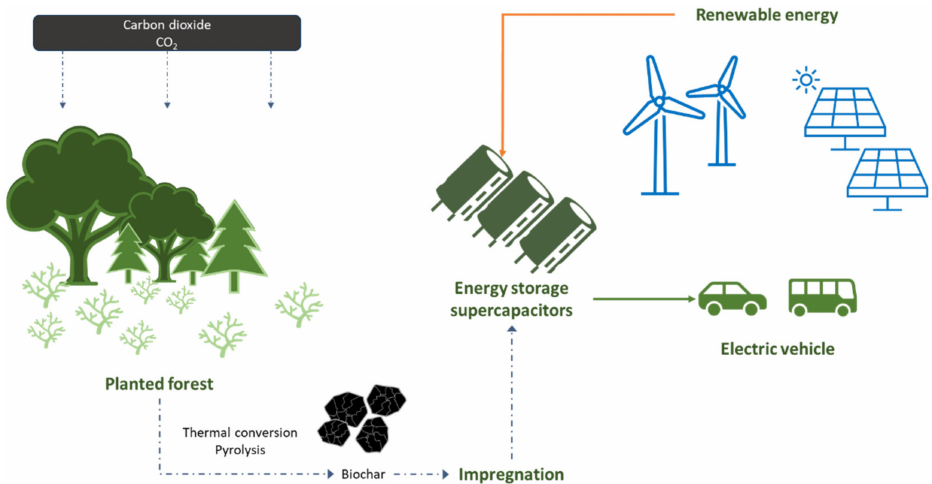
Figure 4. Utilization of biochar in energy storage